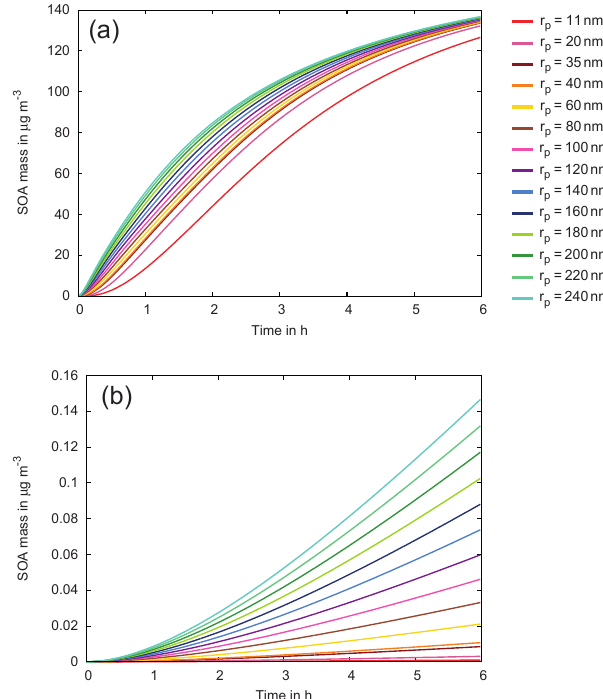
Figure 3. Model results of SOA mass for the variation of the par- ticle radius r p using a constant k c = 1s − 1 (cases 4a and 4b of Table 1) for (a) liquid ( D b = 10 − 12 m 2 s − 1 ) and (b) semi-solid ( D b = 10 − 18 m 2 s − 1 ) aerosol